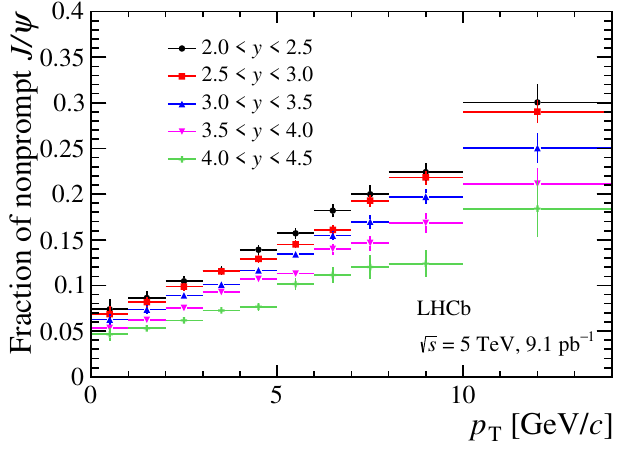
Figure 5 . Fraction of nonprompt J/ψ mesons as a function of p T in intervals of y . The error bars represent the total uncertainties, which are partially correlated between